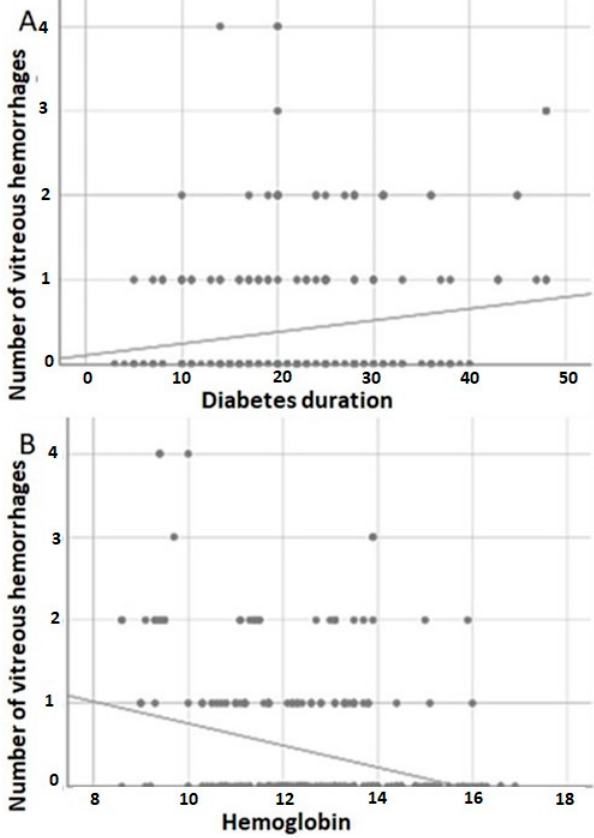
Figure 1. Number of vitreous hemorrhage events as a function of the duration of diabetes and the level of hemoglobin. ( A ) Scatter plot showing a positive correlation between the duration of diabetes and the number of vitreous hemorrhage events. ( B ) Scatter plot showing a negative correlation between the hemoglobin level and the number of vitreous hemorrhage episodes.